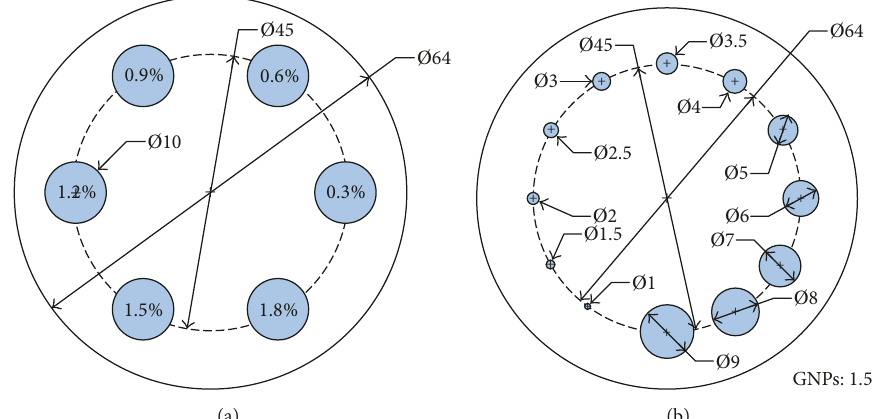
Figure 3: Phantoms contained GNP-loaded regions. (a) GNP-loaded regions with same size in height and diameter but different Au weight concentrations; (b) GNP-loaded regions with same Au weight concentration but different diameters.